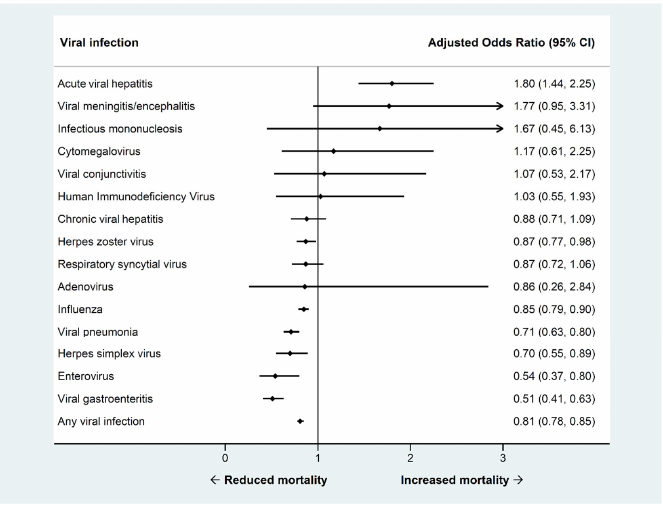
Figure A2. Adjusted odds of in ‐ hospital mortality for patients with a diagnosis of viral infection compared to those without a diagnosis of viral infection in patients admitted with heart failure who are aged greater than 80 years.